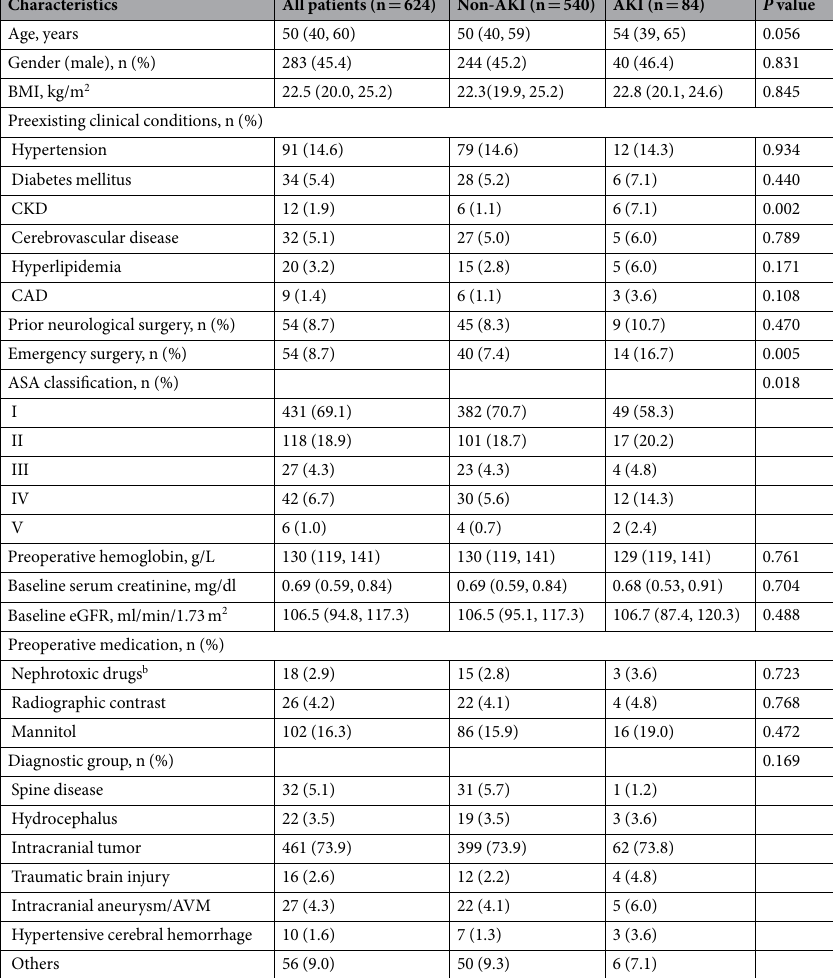
Table 1. Preoperative Patient Characteristics by Status of AKI a . a Continuous variables were expressed